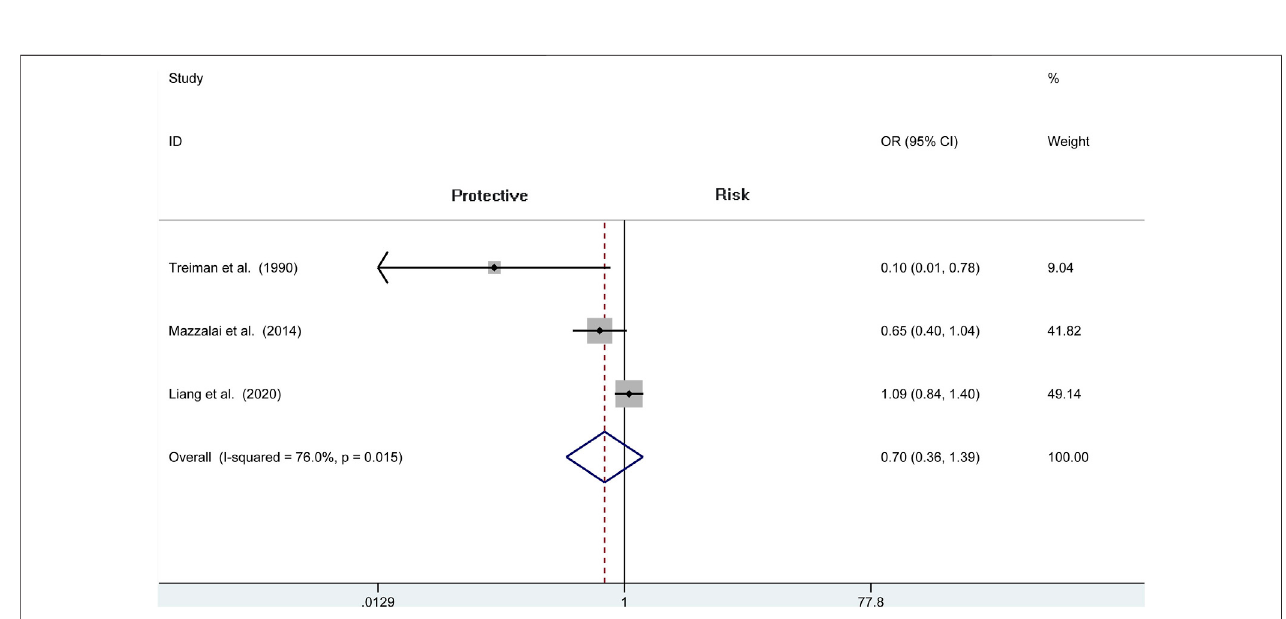
FIGURE 5 | Forest plot for meta-analysis of the incidence of wound hematoma with hypertension.